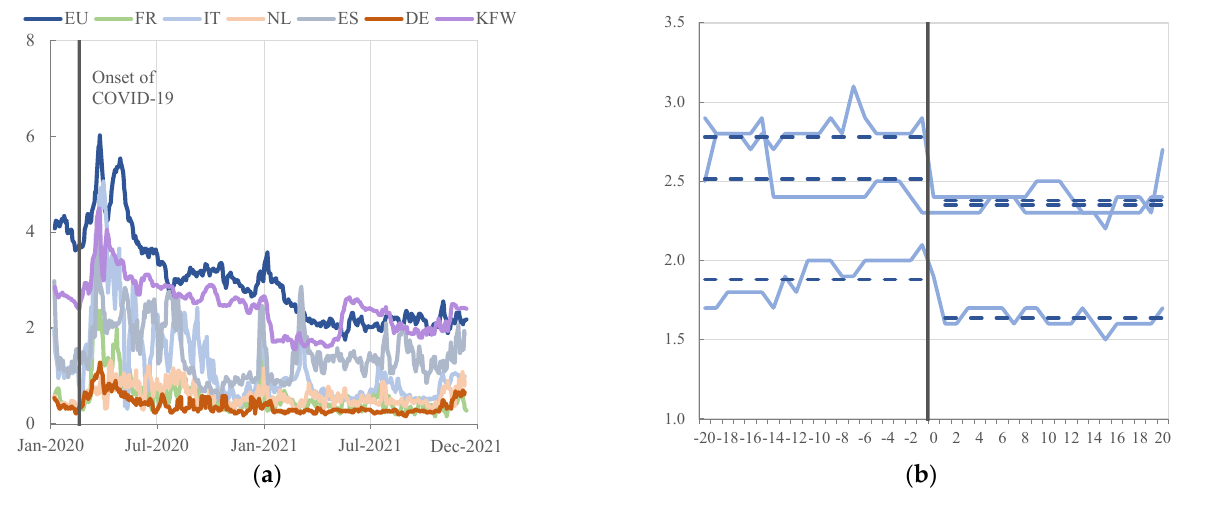
Figure 3. Bid–ask spreads over time and around tapping events. ( a ): Five-day trailing moving average of bid–ask spreads for ten-year benchmark bonds (in bps) between January 2020 and December 2021. ( b ): Bid–ask spreads for the first three taps following the first issuance of SURE bonds (horizontal axis in bps; vertical axis − /+20 days from tap event). The vertical line indicates the respective tap day.